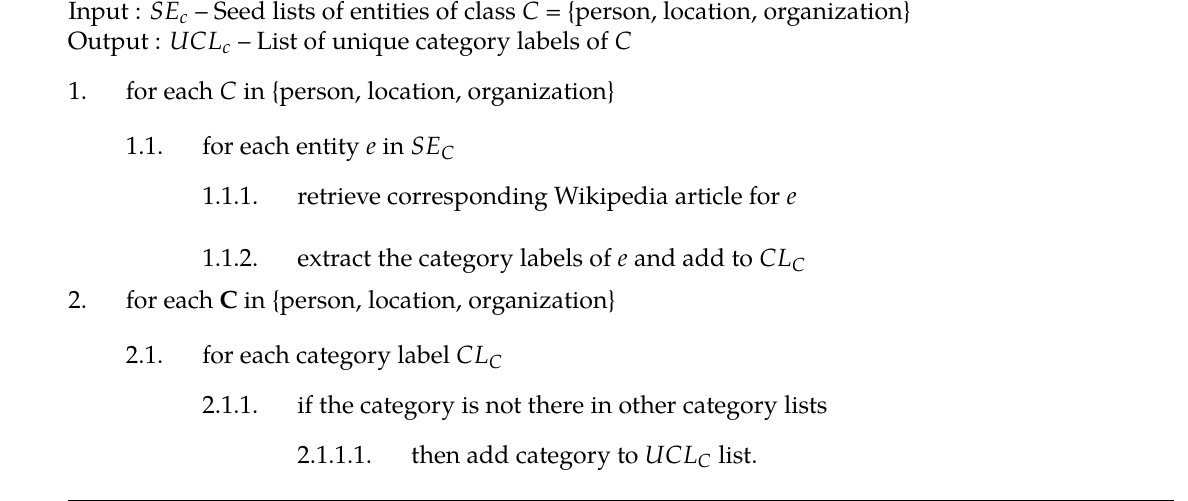
Algorithm 1 Extracting unique category labels for each NE